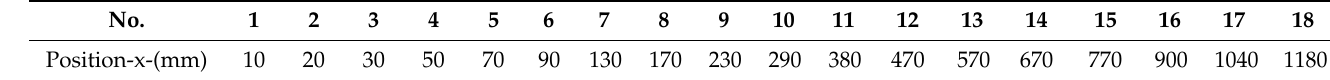
Figure 3. Geometric configurations of twisted tapes. Table 1. Thermocouple’s